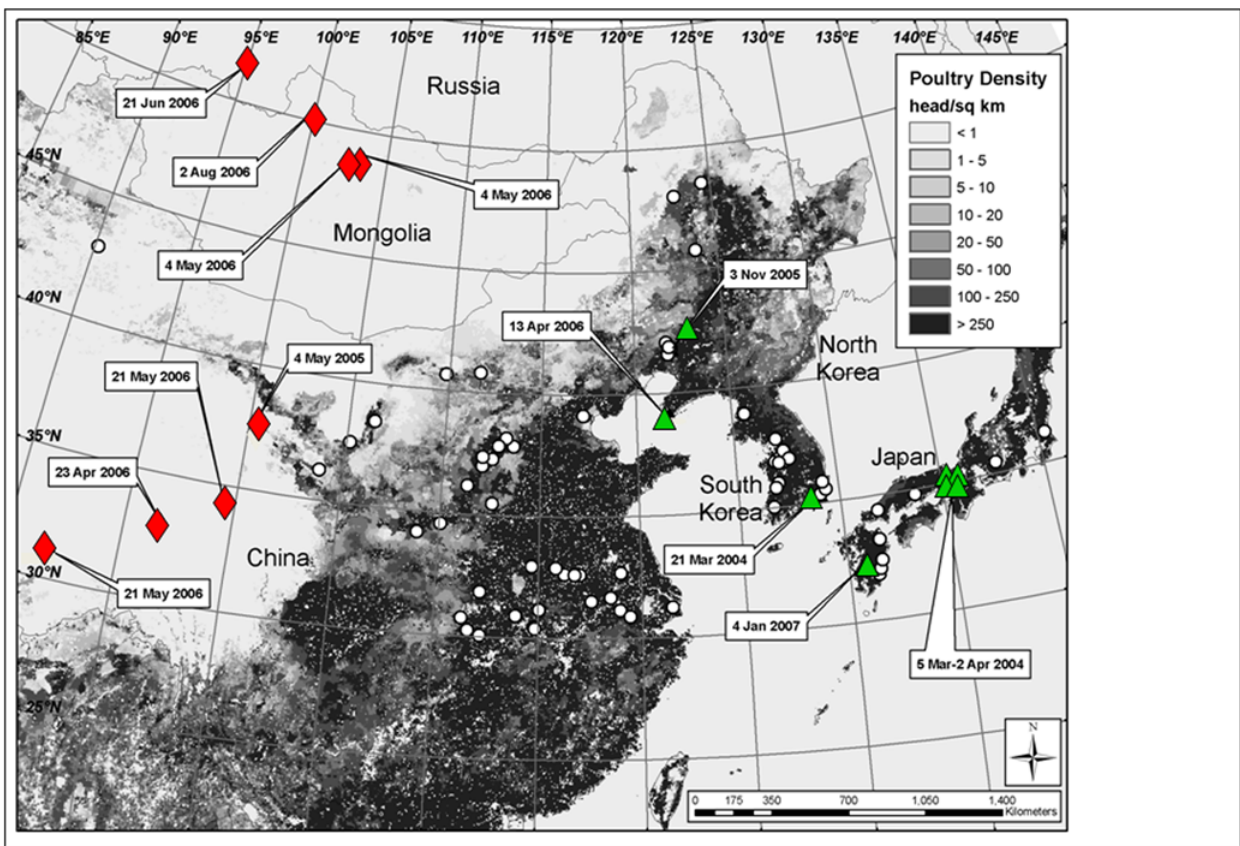
Figure 2. Poultry density and H5N1 outbreak locations [circles (poultry), diamonds (migratory waterbirds), and triangles (wild non- waterbirds)] in eastern Asia (2003–2007).